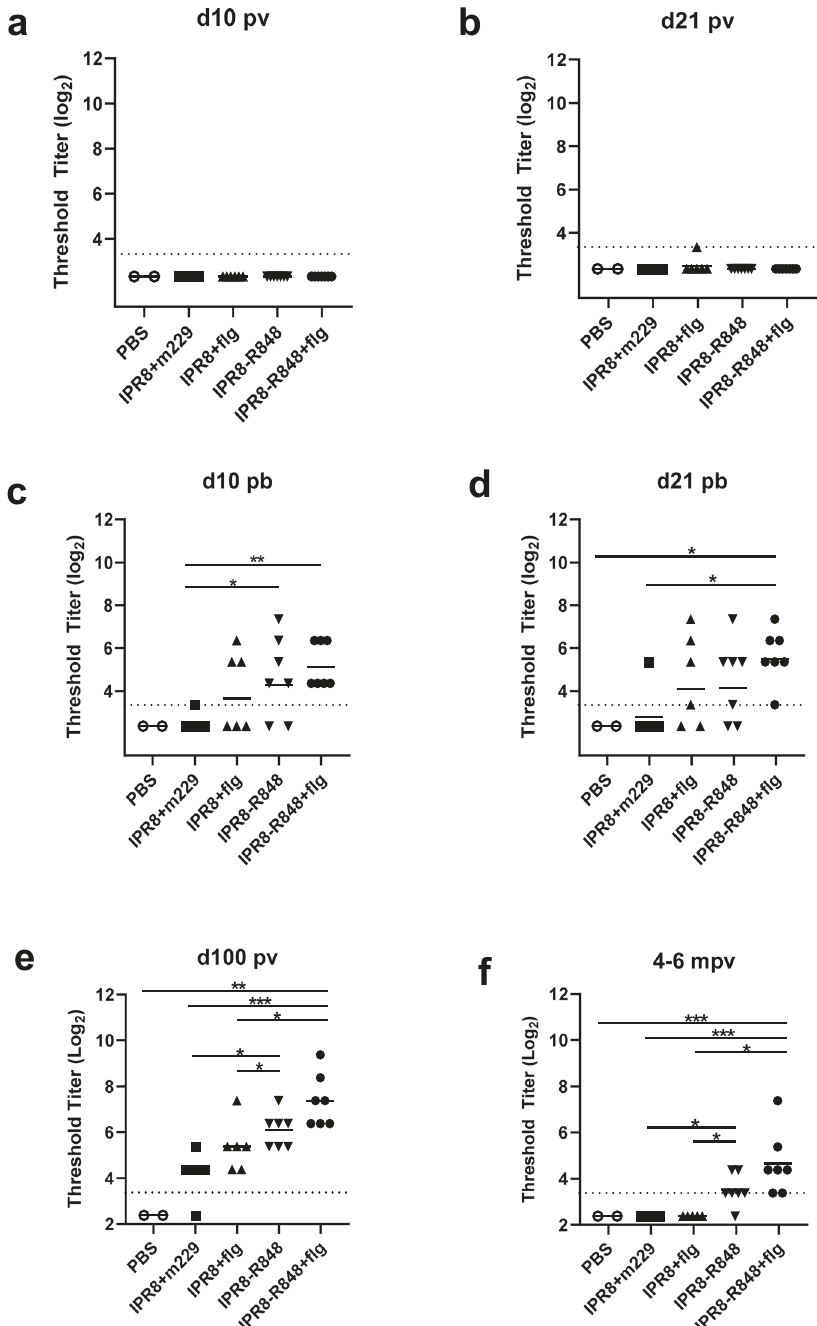
Fig. 1 Vaccination with a TLRa adjuvanted vaccine elicits IgG to the HA stem. Newborn AGM received IPR8 with soluble fl agellin (IPR8 + fl g) ( n = 6), conjugated to R848 (IPR8-R848) ( n = 7), the combination of fl agellin and IPR8-R848 (IPR8-R848 + fl g) ( n = 7), without functional adjuvant (IPR8 + m229) ( n = 5), or PBS as a vehicle control ( n = 3). Newborns were boosted with the same at d21 p.v. Plasma IgG titers to stabilized Ca09 HA stem were measured by ELISA at days 10 and 21 p.v. ( a , b ) or p.b. ( c , d ), approximately d100 p.v. ( e ) and 4-6 months ( f ) following initial vaccination. Data are shown as threshold titer (the lowest dilution at which sample OD was at least three times that of the assay background). The limit of detection (dotted line) is de fi ned as the lowest sample dilution in the assay. Statistical signi fi cance was determined by ordinary one-way ANOVA with uncorrected Fisher ’ s LSD test for multiple comparisons. * p < 0.05, ** p < 0.01. *** p <